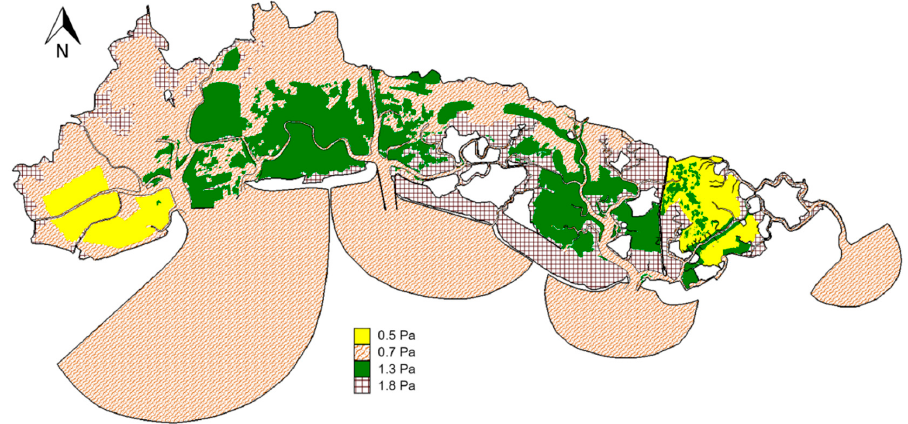
Figure 10. Classes of critical shear stress and assignment to lagoon area.